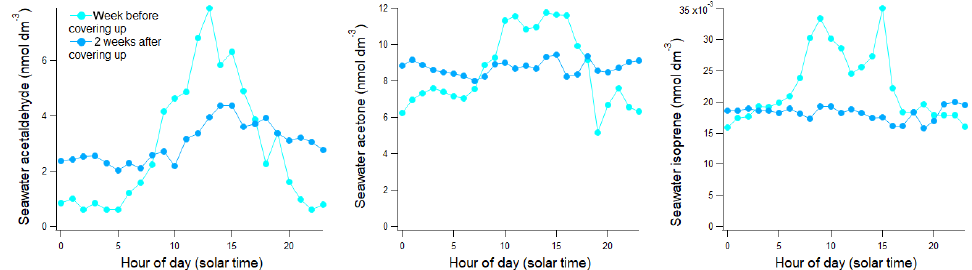
Figure 3. Underway seawater concentrations binned in 24-hourly bins for the week before and 2 weeks after protecting the SFCE equilibrator from sunlight on 4 March